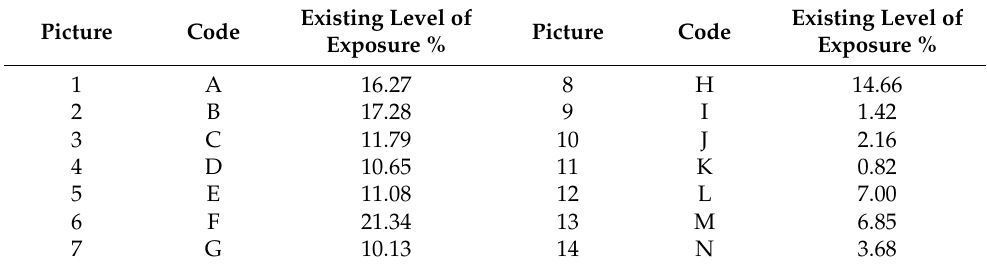
Figure 9. A sample original picture (Code F), the additions made of approximately 5% increments, and the respective RGB histogram. Whereby A represents the original photo, B represents the photo after 1 st addition, and C represents the photo after 2 nd addition.